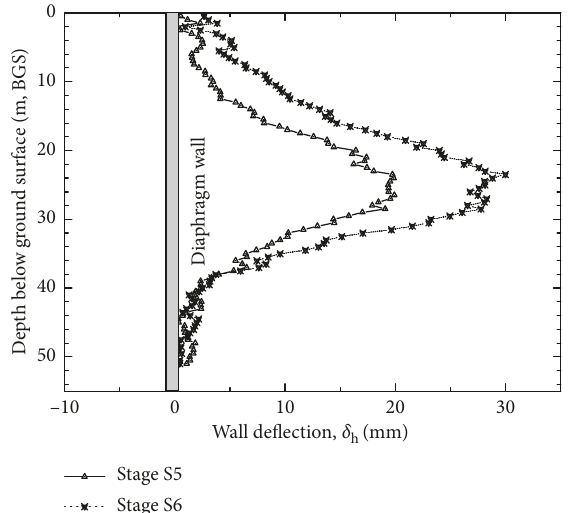
Figure 13: Typical lateral wall deflection.